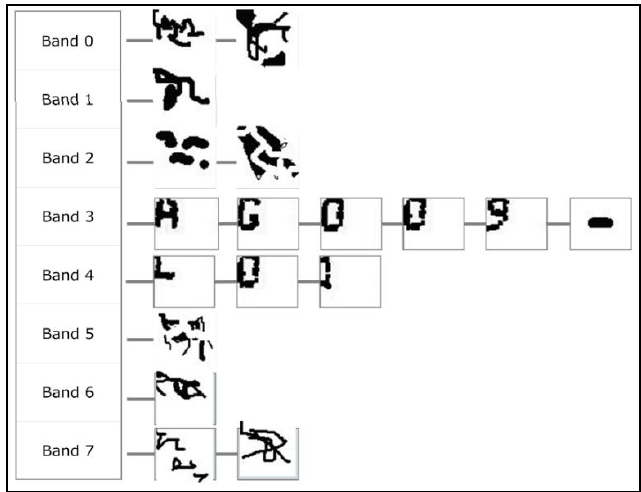
Figure 5. Set of shapes (morphologies) ordered from top to bottom by bands and arranged from left to right. In a typical case some of these morphologies correspond to characters (all morphologies in bands 3 and 4), but others are noise (all morphologies excluding those in bands 3 and